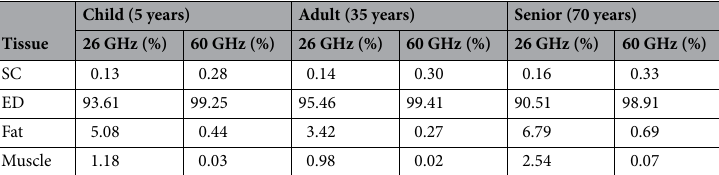
Table 2. Percentage of total absorbed power in SC, ED, fat and muscle at 26 GHz and 60 GHz for a child (5 years), an adult (35 years) and a senior (70 years).